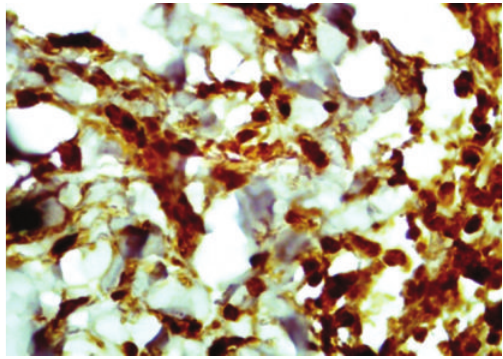
Figure 3: Of patient no. 1 showing leishmania antigen in dermal macrophages. The small round bodies in some cells are probably leishmania parasites that were not detected in the H&E-stained sections.